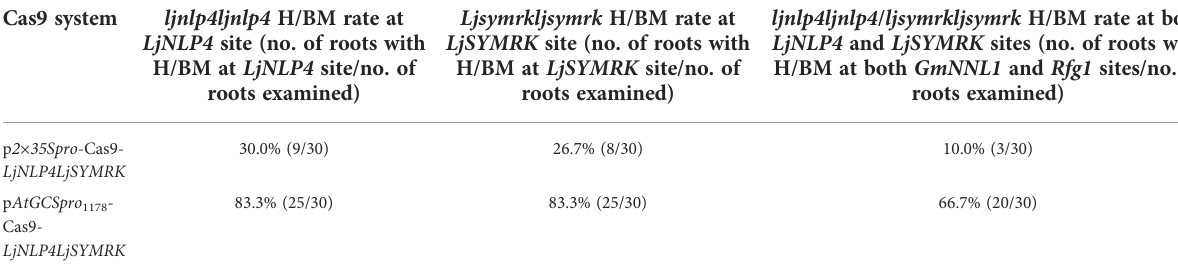
TABLE 4 Comparison of p AtGCSpro 1178 -Cas9 -LjNLP4LjSYMRK and p2× 35Spro -Cas9 -LjNLP4LjSYMRK genome editing ef fi ciency in L . japonicus hairy roots. Cas9 system